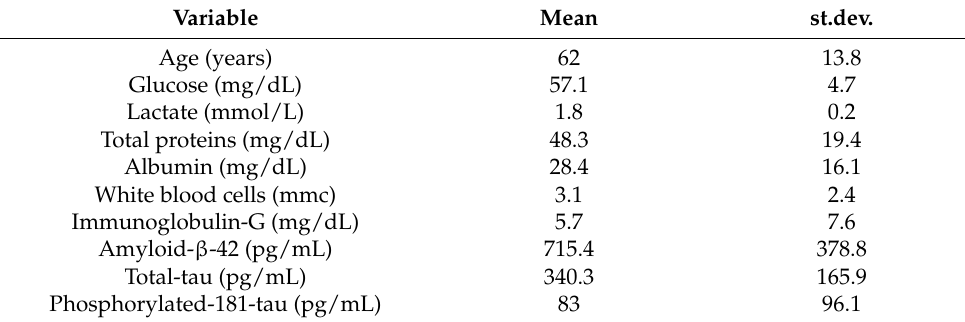
Table 4. Clinical and demographic data of the study